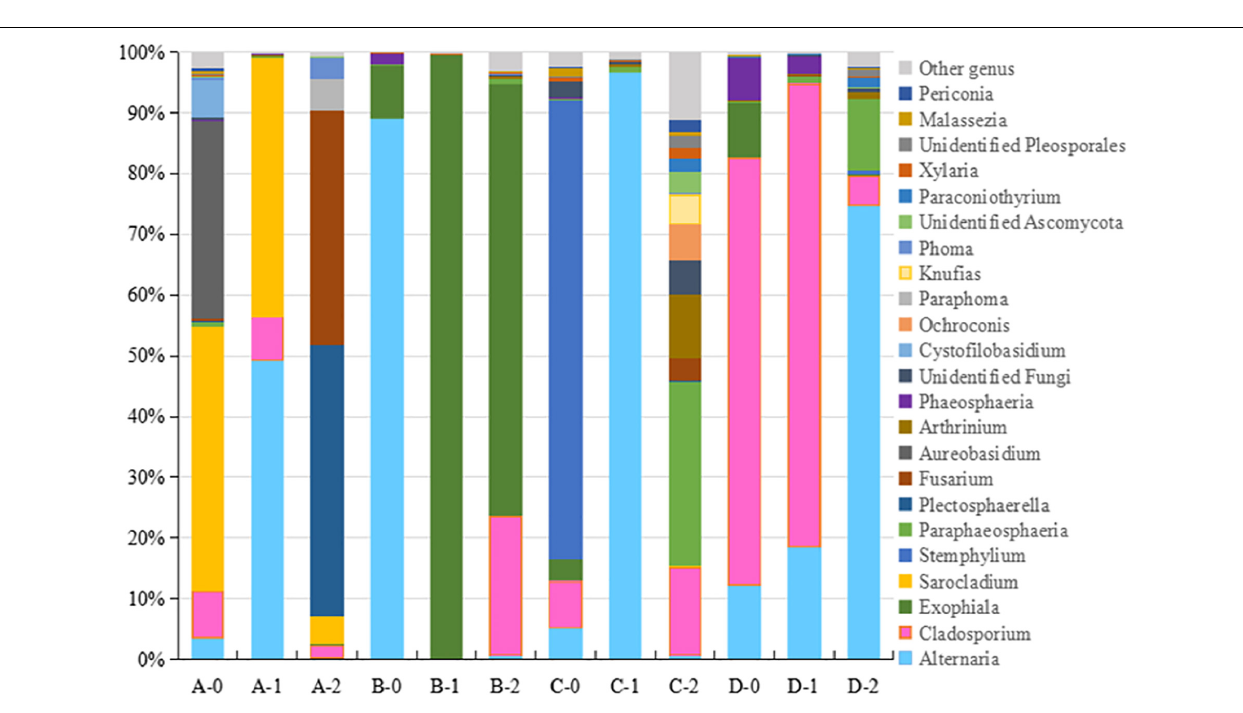
FIGURE 2 | The taxonomic diversity of fungi at genus level 4 locations. A, B, C, D: location; 0: 0.05 m depth sediment (surface); 1: 1 m depth sediment; 2: 2 m depth